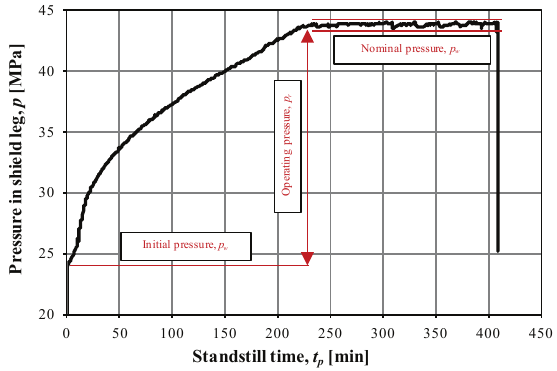
Figure 1: Pressure ranges in the powered supports Source: Author’s own sources.